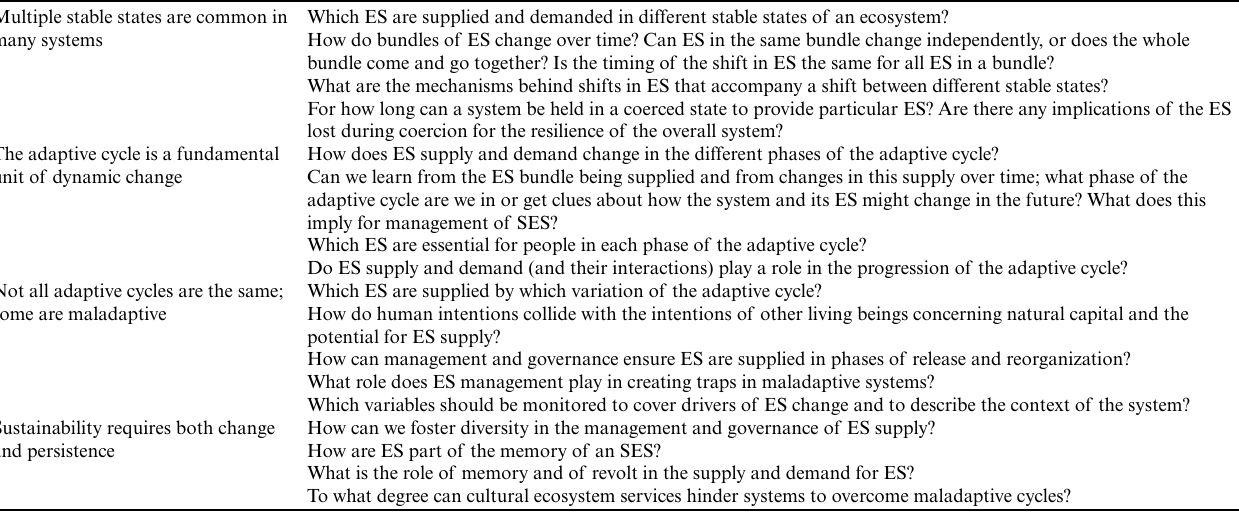
Table 1 . Potential research questions occurring for ecosystem services (ES) research based on the four Panarchy conclusions. Multiple stable states are common in Which ES are supplied and demanded in different stable states of an ecosystem? many systems How do bundles of ES change over time? Can ES in the same bundle change independently, or does the whole bundle come and go together? Is the timing of the shift in ES the same for all ES in a bundle? What are the mechanisms behind shifts in ES that accompany a shift between different stable states? For how long can a system be held in a coerced state to provide particular ES? Are there any implications of the ES lost during coercion for the resilience of the overall system? The adaptive cycle is a fundamental unit of dynamic